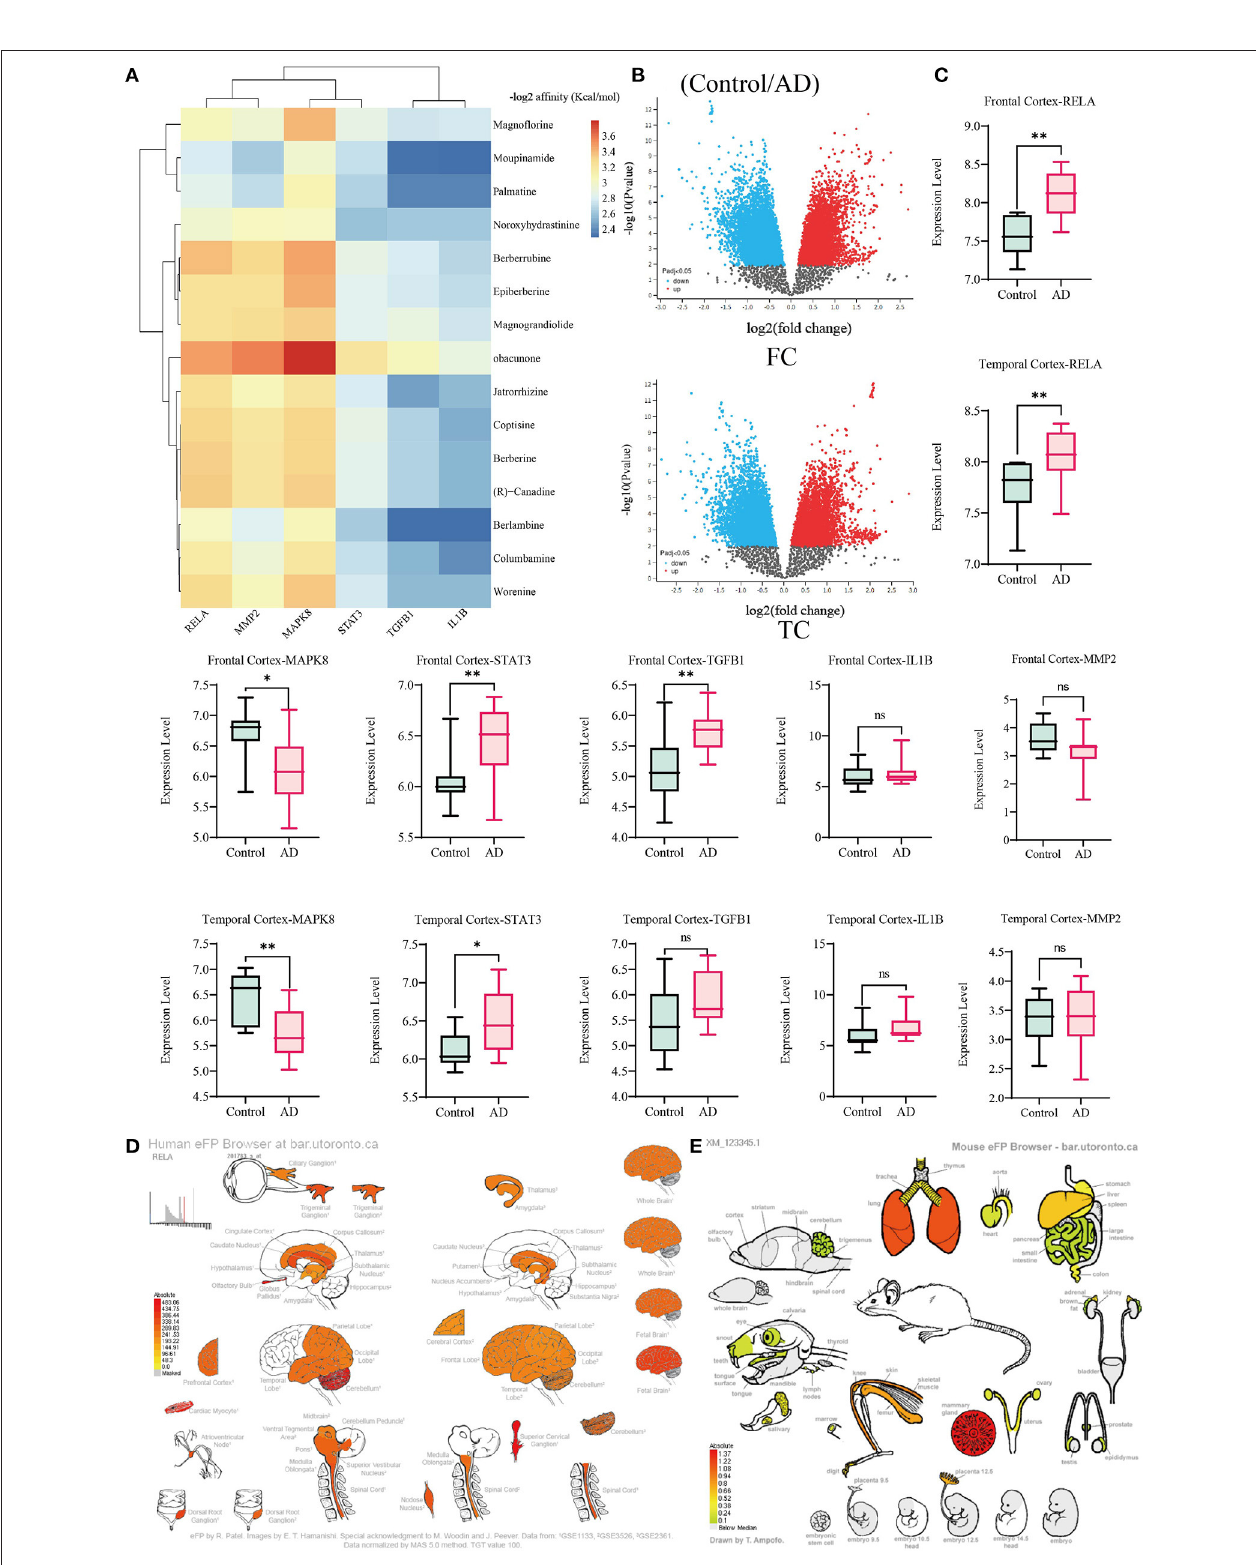
FIGURE 10 | Core gene expression analysis. (A) Composition-Target binding energy heat map. (B,C) Analysis of AD Gene mRNA expression based on GEO dataset. (D) Analysis of the expression of RELA in the regular human nervous system. (E) Analysis of RELA expression in tissues and organs of normal mice. * p < 0.05, ** p <